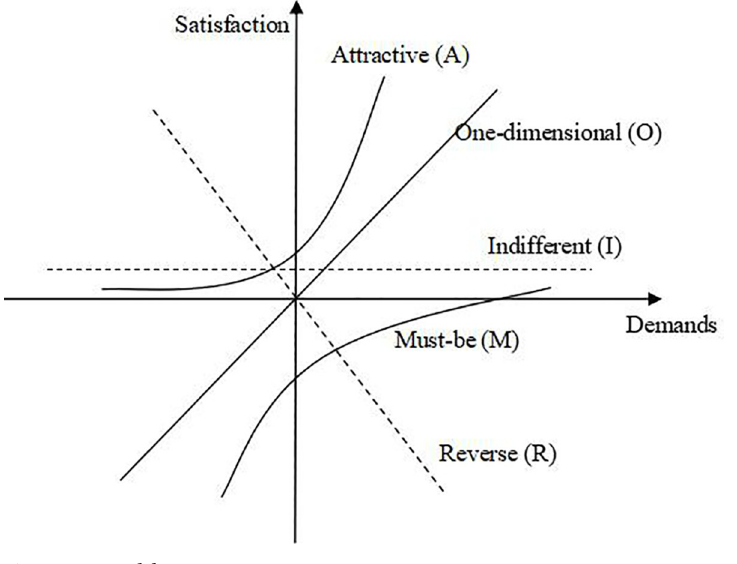
Fig 3. Kano model.